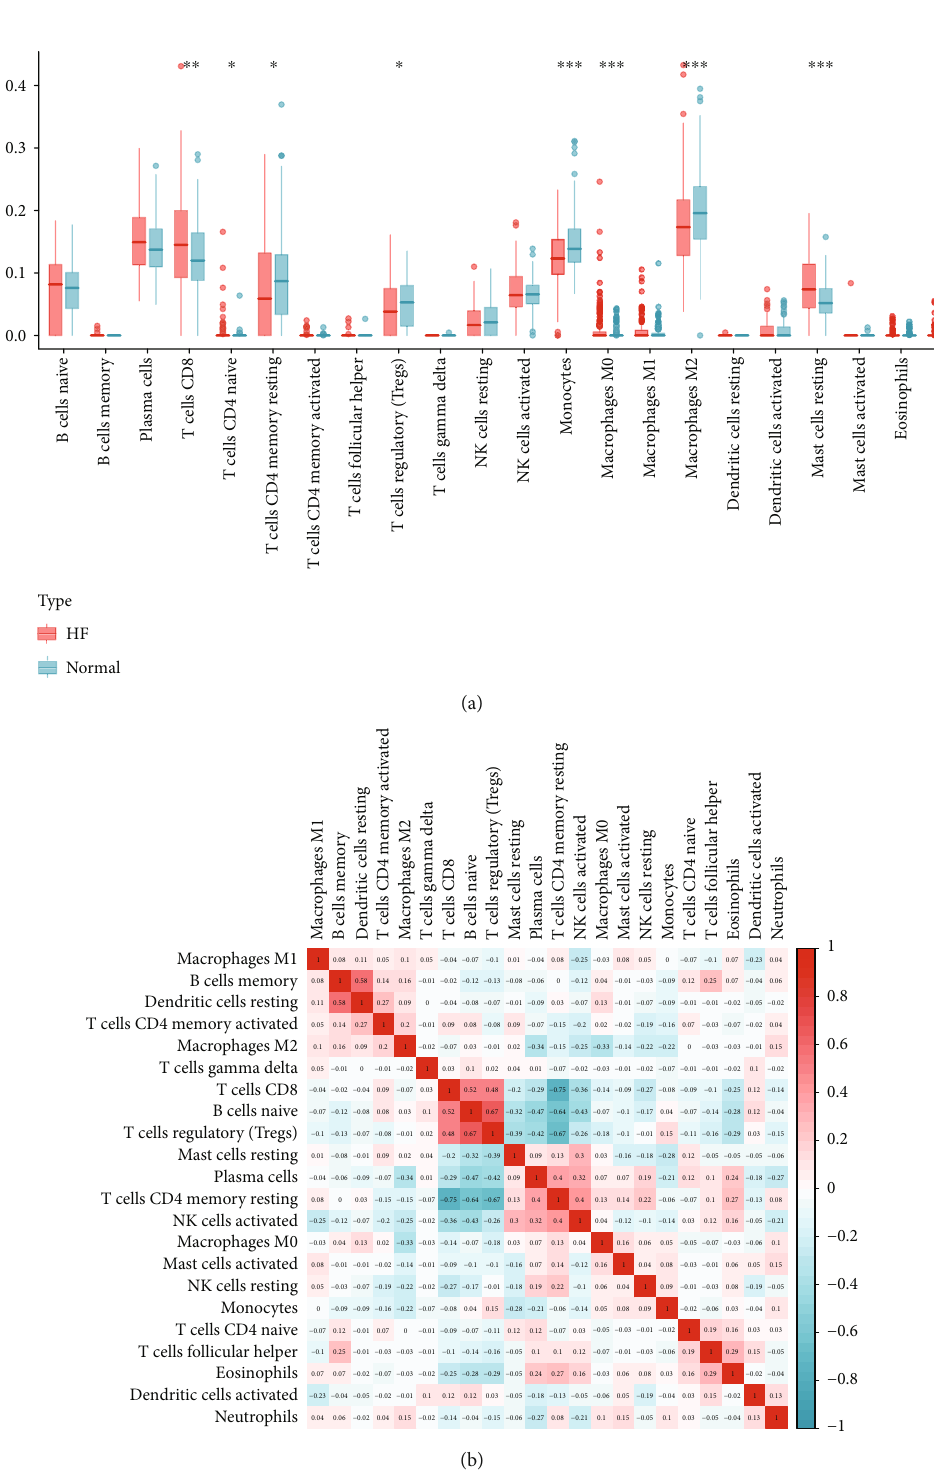
Figure 5: Tissue immune cell in fi ltration. (a) Immune cell di ff erence between HF and normal samples ( “ ∗∗∗ ” means P < 0 : 001 , “ ∗∗ ” means P < 0 : 01 , “ ∗ ” means P < 0 : 05 ). The red dots represent each HF sample, while the blue dots represent each normal sample; (b) immune cell subtype correlation. The speci fi c correlation values of 22 immune cells are displayed, in which the darker color of each correlation square represents higher correlation, and the lighter color represents low correlation. Red represents the degree of positive correlation, while blue represents the degree of negative